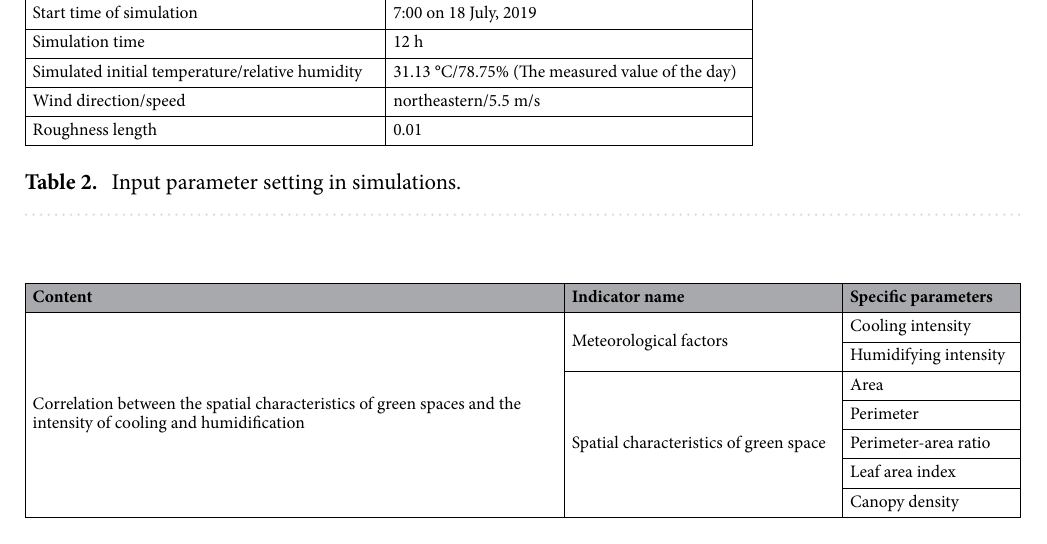
Table 3. Parameter structure of the cooling and humidification effect based on the spatial characteristics of green